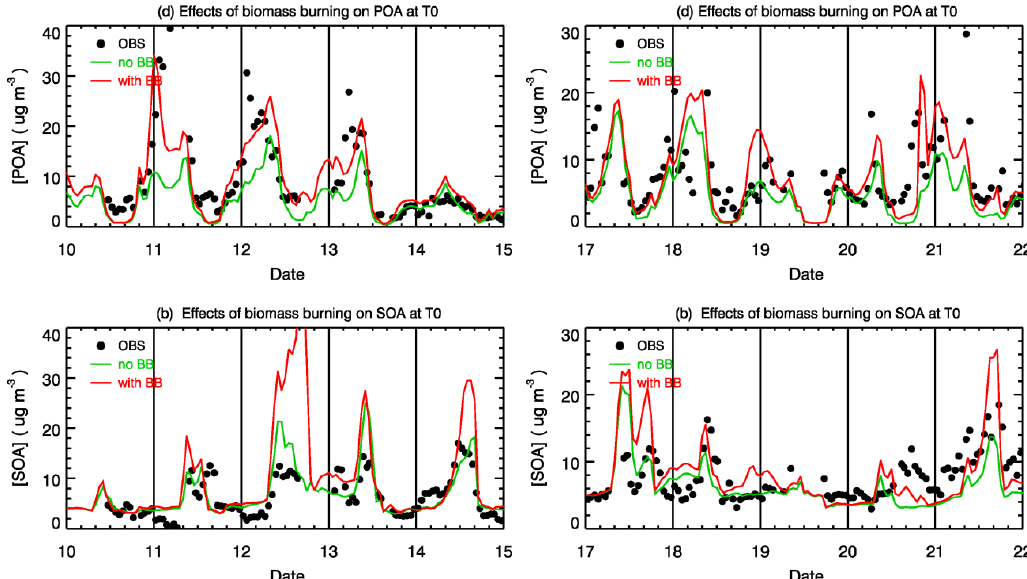
Fig. 8. Comparisons of observed and simulated POA (top panels) and SOA (bottom panels) at T0. Green lines denote the case without the BB emissions, while red lines denote the case with the BB